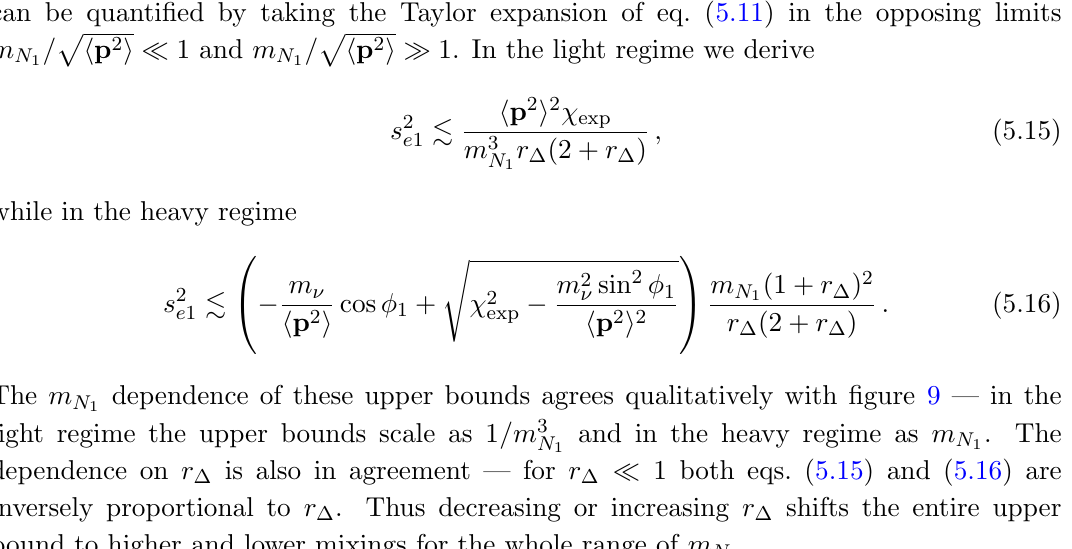
amplitide of LNV is controlled by the ratio (cid:0) N = (cid:1) m N . By considering the open sterile neutrino decays to SM particles we found (cid:0) N = (cid:1) m N = (cid:0) N = ( r (cid:1) m N range 5 GeV . m N